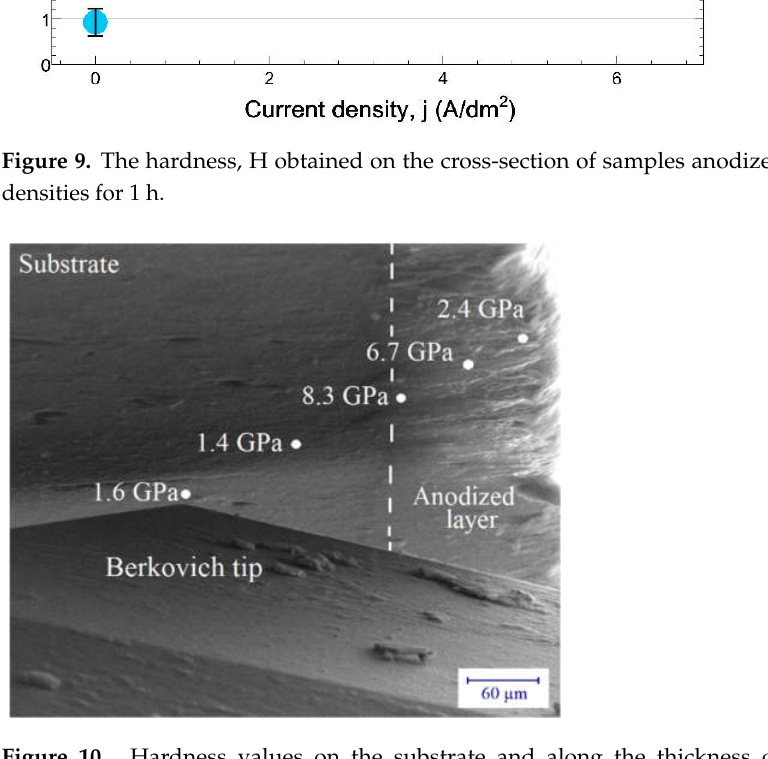
Figure 10. Hardness values on the substrate and along the thickness of an anodized layer (j = 6 A/dm 2 , t = 1 h), obtained by using the combination of SEM and